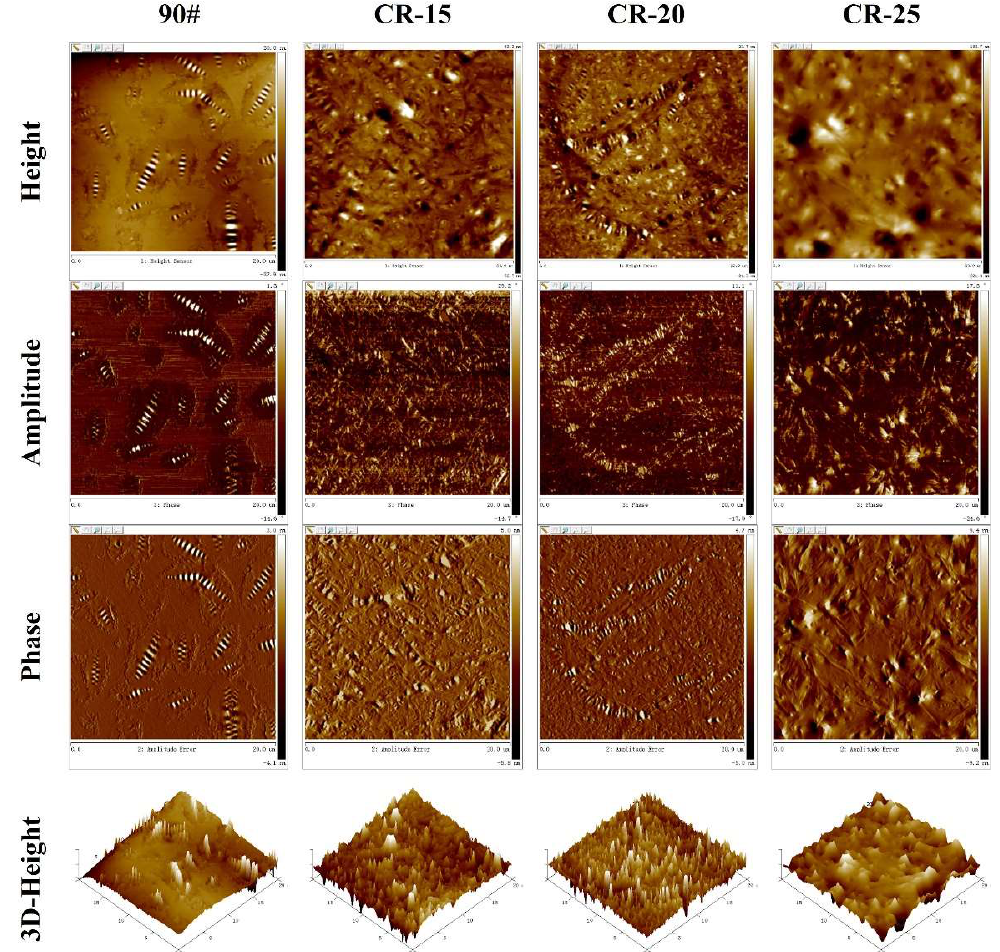
Figure 10. AFM diagrams of different rubberized asphalts. The common roughness indices are [57].